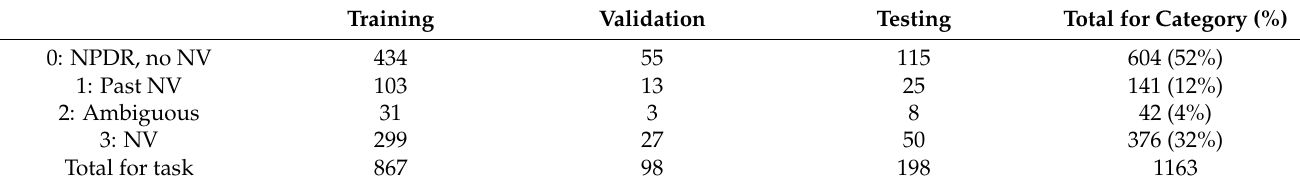
Table 1. Image categories. Most images (52%) had no NV. 32% had active NV, while 12% had evidence of treatment for previous NV but no active lesions; a minority (4%) had clinically ambiguous lesions. Training Validation Testing Total for Category